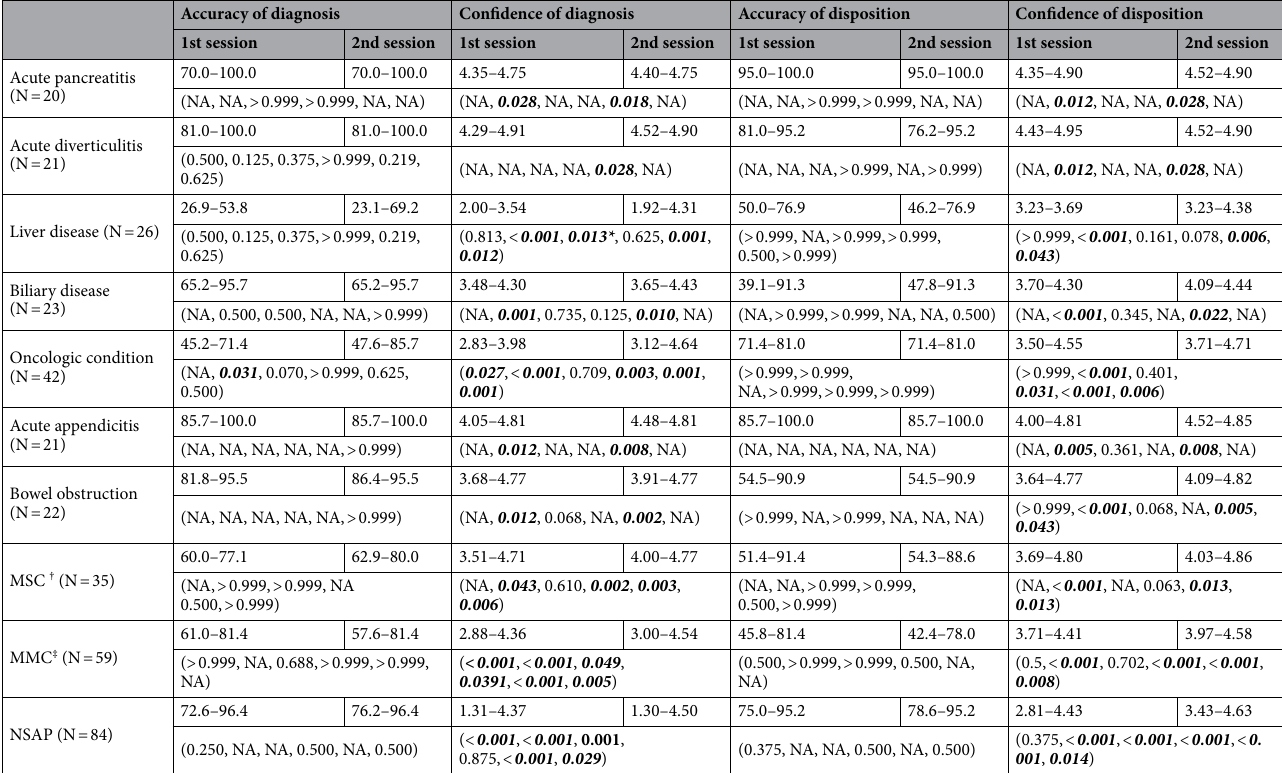
Table 2. Subgroup Analysis by Disease Category. NOTE. NA = not available, MSC = miscellaneous surgical condition, MMC = miscellaneous medical condition, NSAP = nonspecific abdominal pain. Numbers are ranges of accuracy or confidence of diagnosis and disposition reported by six radiologists in 1st and 2nd sessions of image review. Numbers in parentheses are P values. McNemar’s test and Wilcoxon test were performed for each radiologist between 1st and 2nd sessions for comparison of accuracy and confidence, respectively. † Miscellaneous surgical condition includes bowel perforation, bowel strangulation, acute mesenteric ischemia, common hepatic artery pseudoaneurysm after pancreas resection, acute aortic syndrome and ovarian cyst rupture. ‡ Miscellaneous medical condition includes urinary tract infection, urinary tract stone, enterocolitis, past or active upper or lower GI bleeding, peptic ulcer and intraabdominal abscess requiring percutaneous drainage. *One of experienced radiologists (ER3) reported statistically significant decrease of